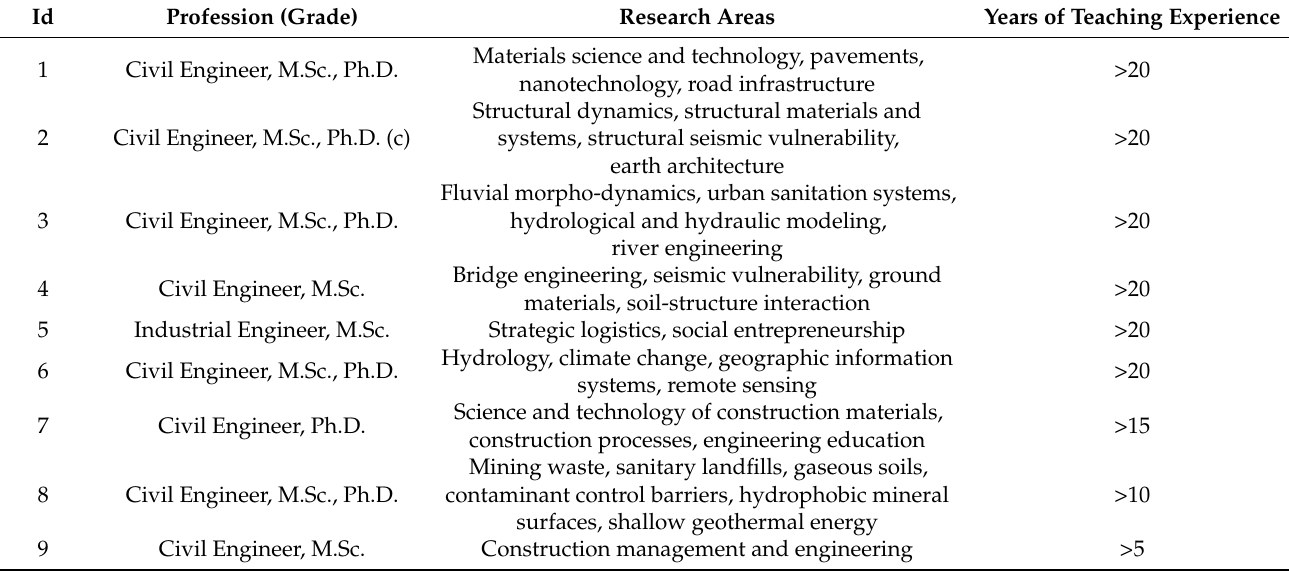
Table 4. Game evaluator professors.